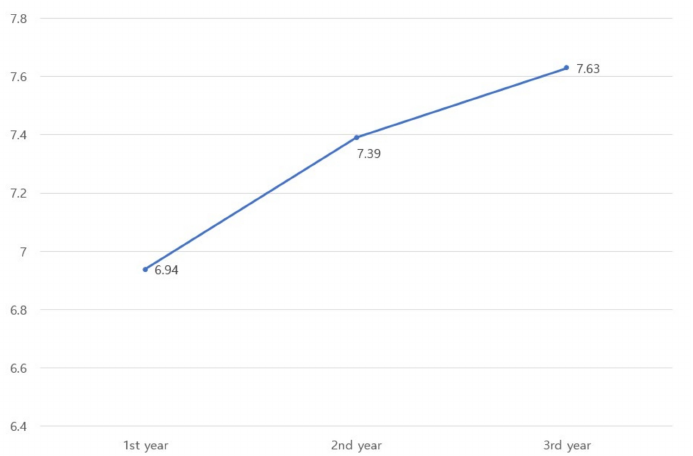
Figure 2. The change in the subject’s job performance over time (mean).